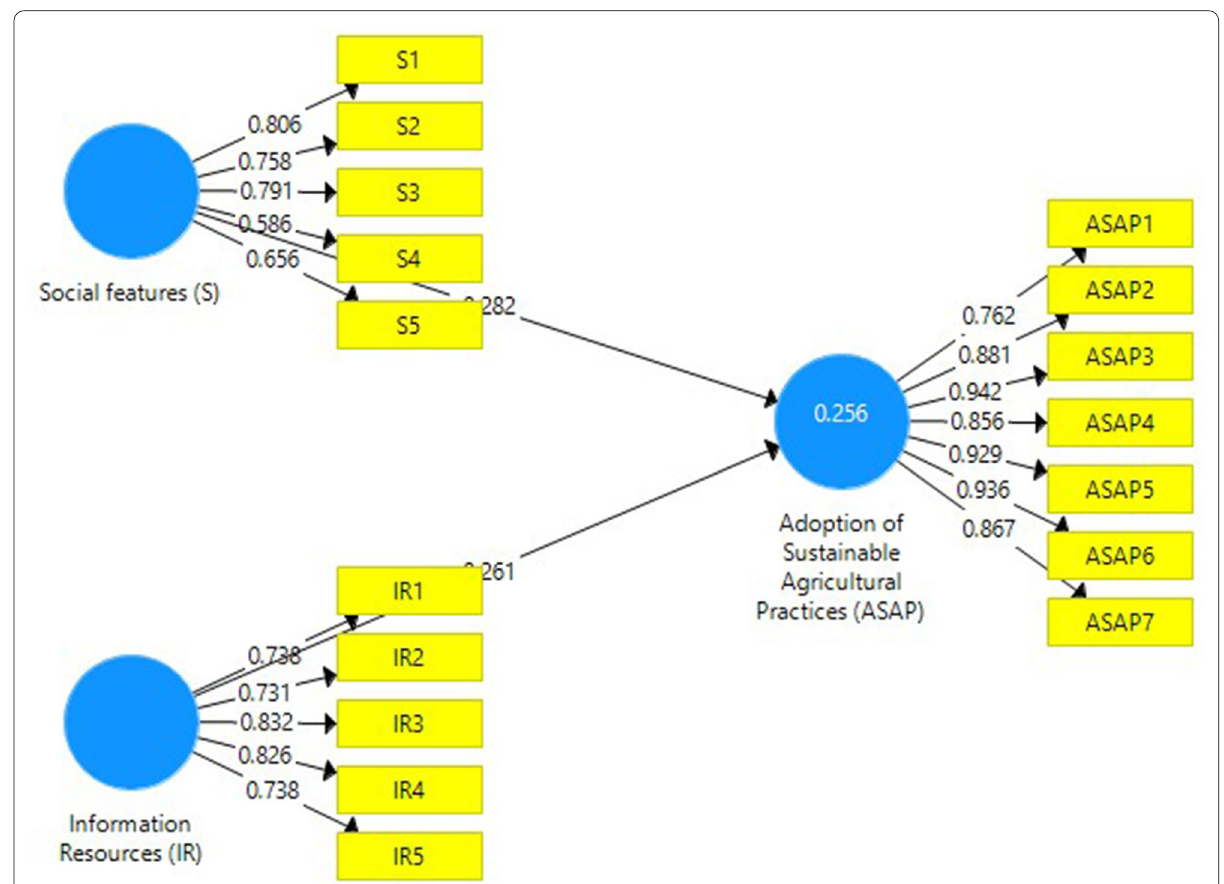
Fig. 2 Graphical linkage between constructs on sustainable agriculture adoption